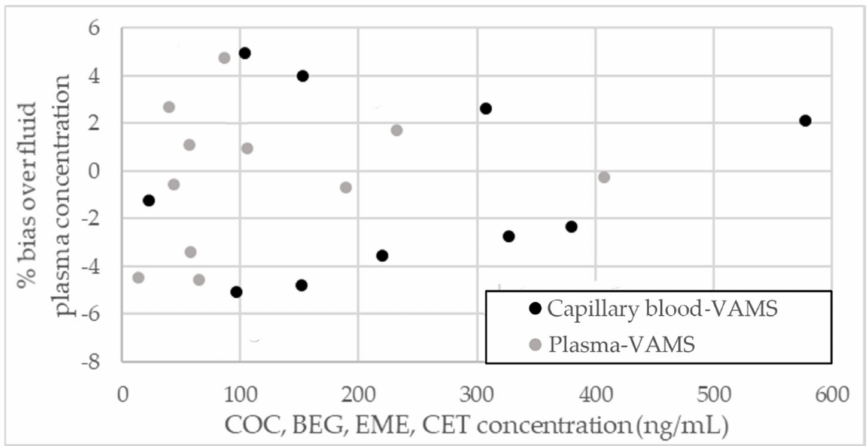
Figure 4. Analyte level comparison between dried micromatrices and fluid